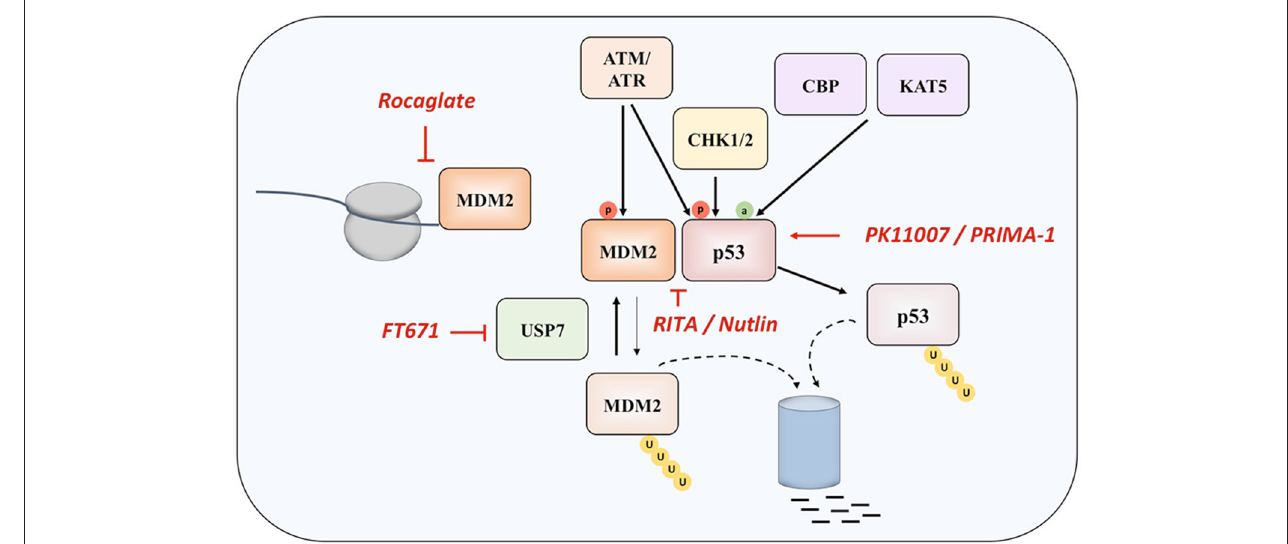
FIGURE 2 | Interacting with TP53 pathway. Different drugs interacting with MDM2 and p53 (in